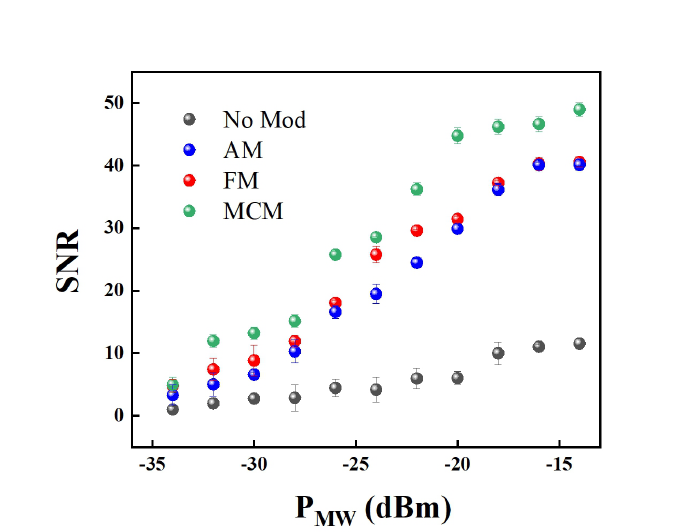
Figure 4. The SNR of right transmission signals of the AT splitting versus the microwave E-field power with different modulation methods.